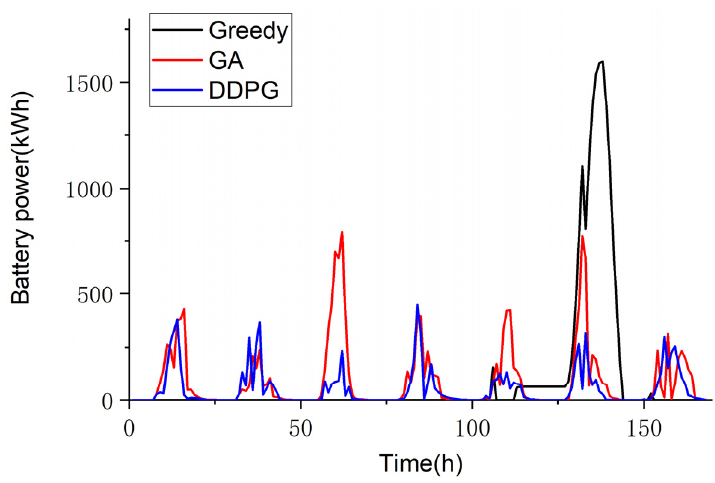
Figure 12. Battery power curve of energy management experiments .